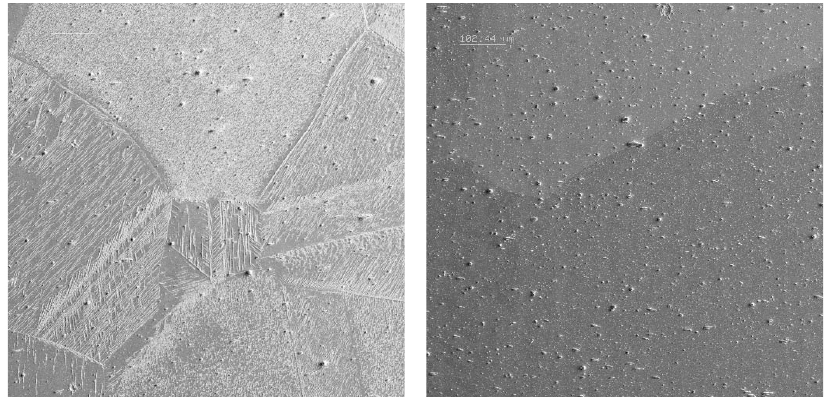
FIG. 26. A comparison between a region in the area of maximum temperature rise (left panel) and the center of the end cap in which the temperature rise is close to zero (right panel). The length scale is 100 : 7 (cid:3) m .